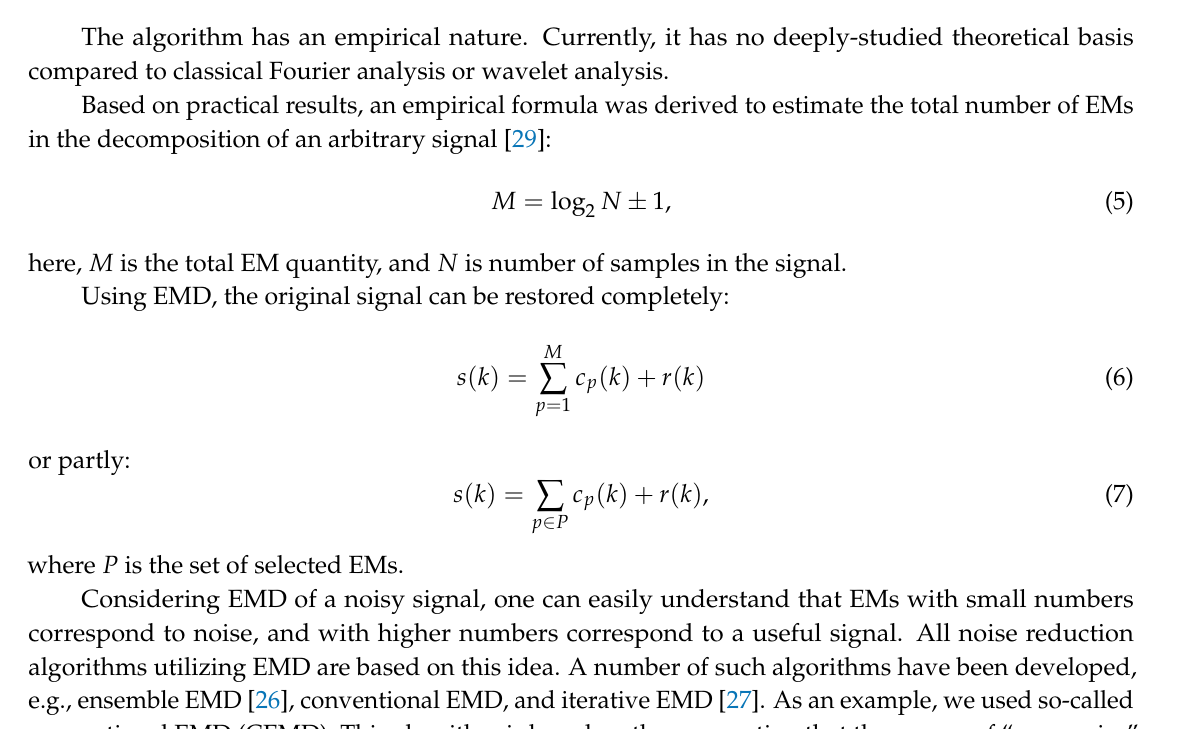
Figure 8. The EMD algorithm.